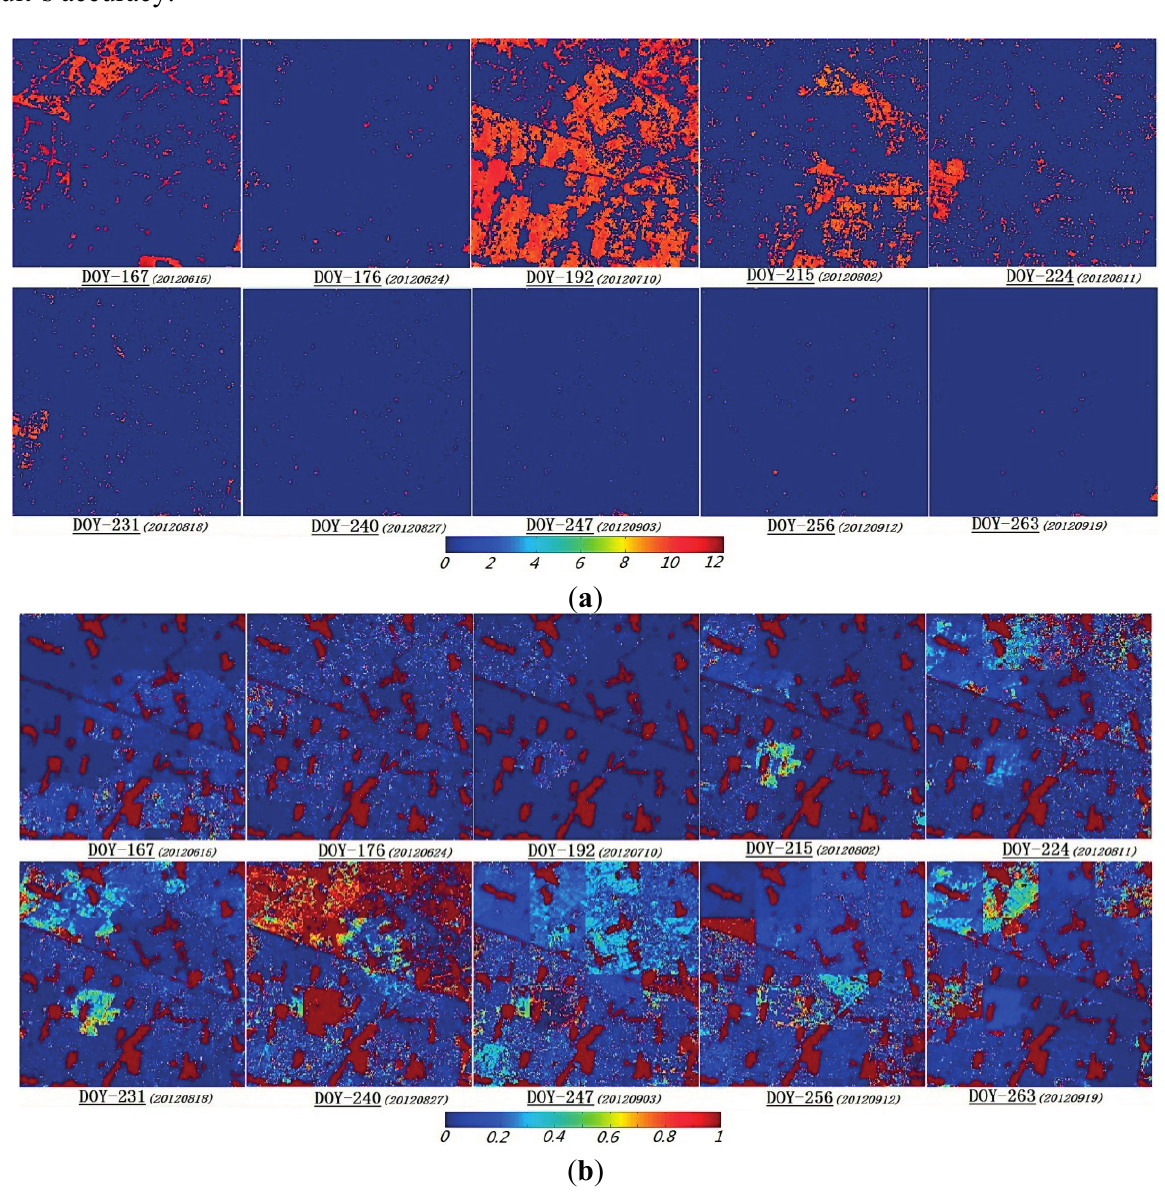
Figure 6. The updated high-resolution remote-sensing observation results for the information entropy and maximum probability; ( a ) information entropy, ( b ) maximum